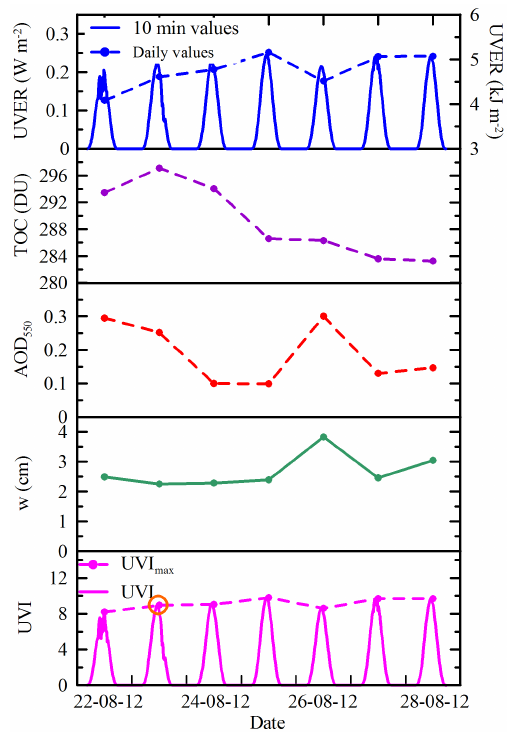
Figure 2. 10min and mean daily values of UVER and UVI, and TOC, AOD 550 and w from satellites at Marsaxlokk in the period 22–28 August